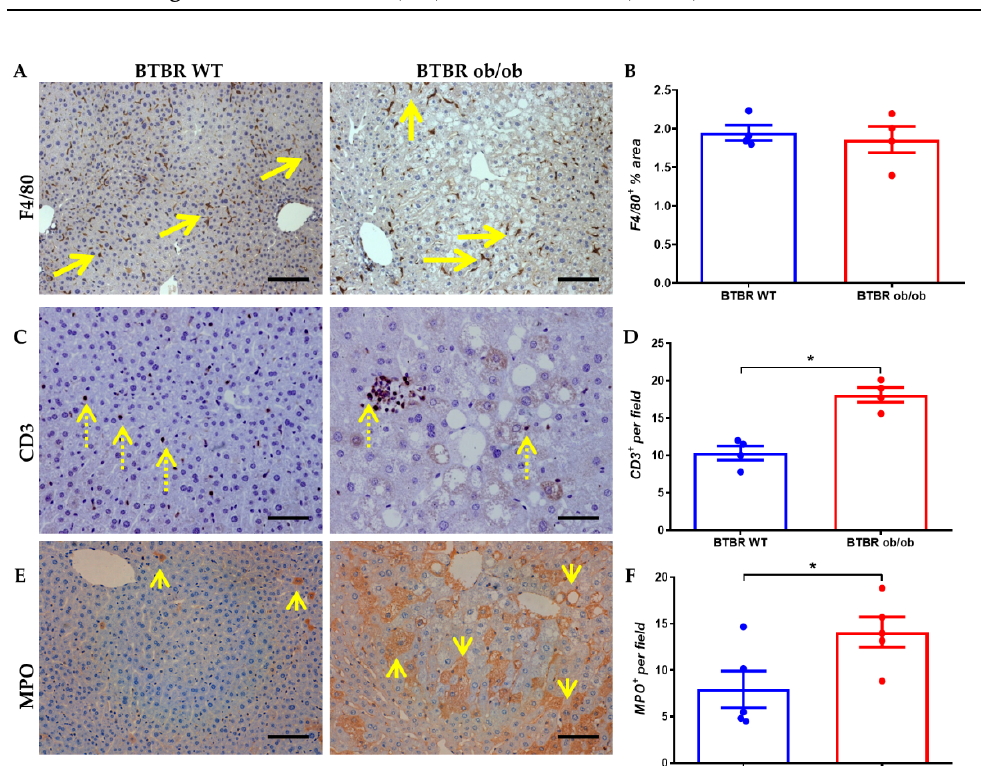
Figure 2. Inflammatory infiltrate in BTBR WT (left) and BTBR ob/ob mice (right) at 12 weeks. ( A ) Representative image of monocytes/macrophages infiltration (F4/80+ staining; long arrow) (magnification 100×), and F4/80+ area quantification ( B ). ( C ) Representative image (of lymphocytes T (CD3; dotted arrow) staining (magnification 200×) and its quantification ( D ). ( E ) Myeloperoxidase (MPO; short arrow) immunostaining (magnification 200×) and quantification of the positive cells per field ( F ). Data are shown as scatter dot plots and mean ± SEM of each group ( n = 5 mice/group); * p < 0.05 vs. BTBR WT .